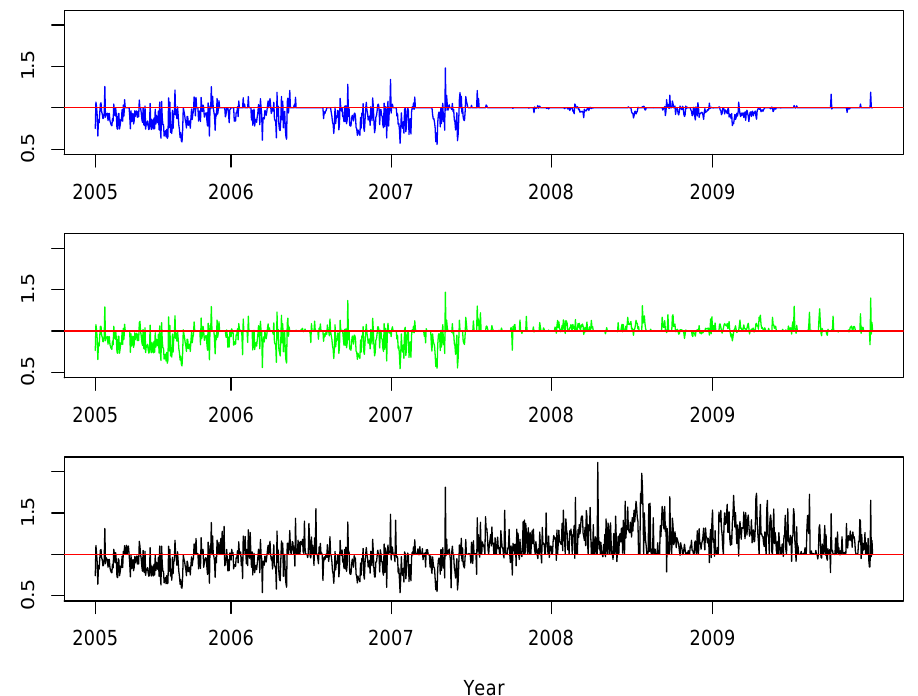
( (cid:101) w t , (cid:101) L t ) / σ 2 Figure 9. Ratios σ 2 for the HAR, AR(5), and AR(1) models, from above to below. t low, t Note: the red lines correspond to a ratio of one, indicating equal